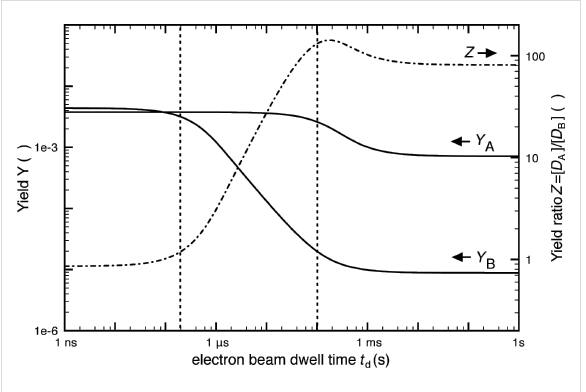
Figure 17: Calculated changes in dissociation yields Y A and Y B (per primary electron as defined in Equation 66 and Equation 67) and yield ratio Z versus electron beam dwell time. The example shown here was calculated for Co 2 (CO) 8 and octanol as the deposition species “A” and “B”, respectively. The yield ratio Z is a measure for the ratio of non- volatile fragments of molecule “a” and “b” incorporated into the FEBID material. Taken from